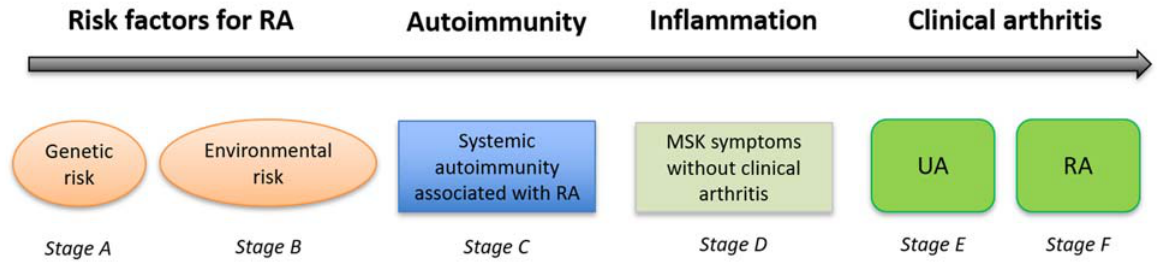
Figure 1. Overview of the pre-clinical phases of RA. Stages along the RA ‘continuum’ defined by the European League Against Rheumatism (EULAR) Standing Committee on Investigative Rheumatology. Legend: MSK: musculoskeletal; RA: rheumatoid arthritis, UA: undifferentiated arthritis.